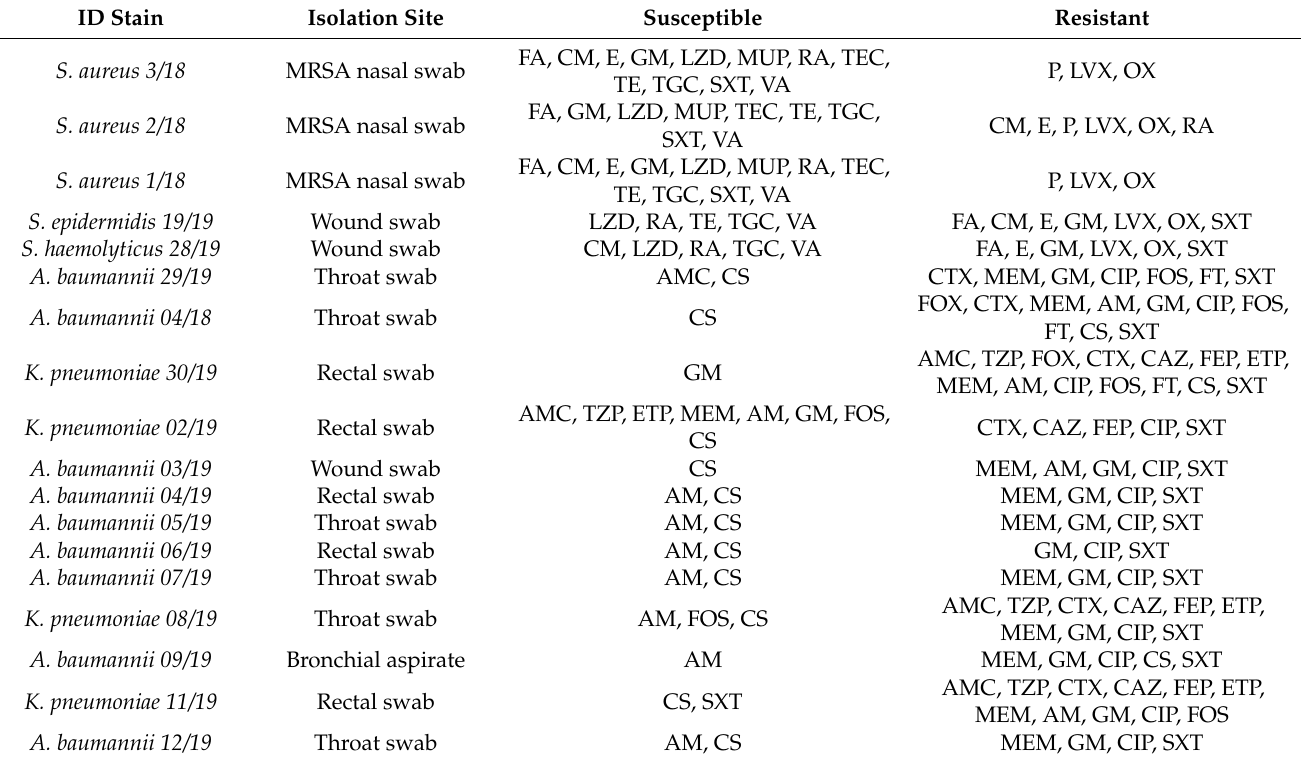
Table 2. Isolation site and antibiotic resistance profiles of clinical